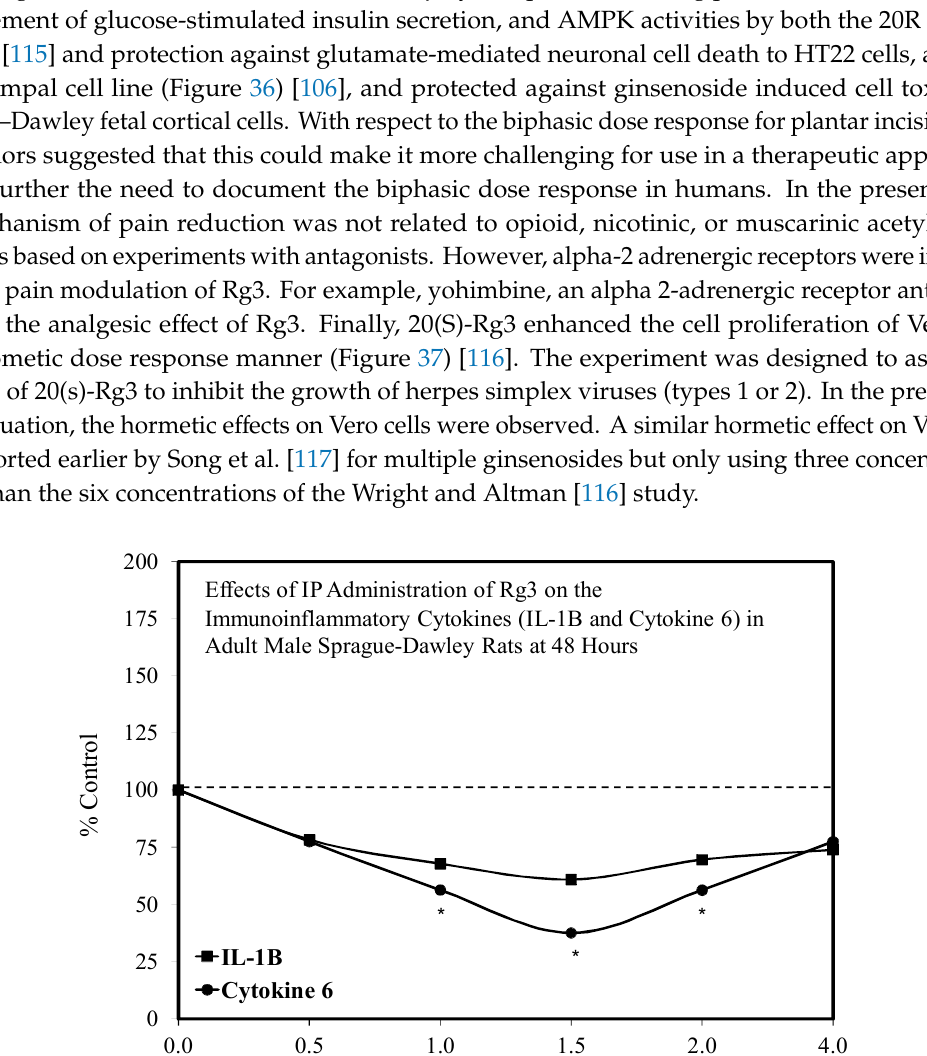
Figure 36. Effects of ginsenoside Rg3 on cell viability of H722 cells, a hippocampal neuronal cell line (source: [106]). Each * represent statistical significance for a data point.